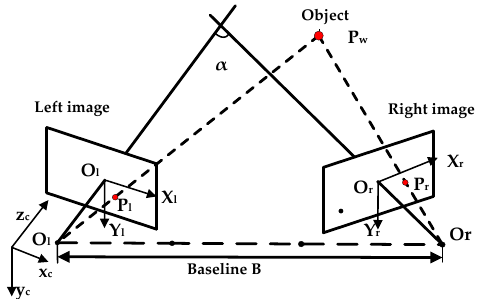
Figure 2. Principle of binocular stereo vision